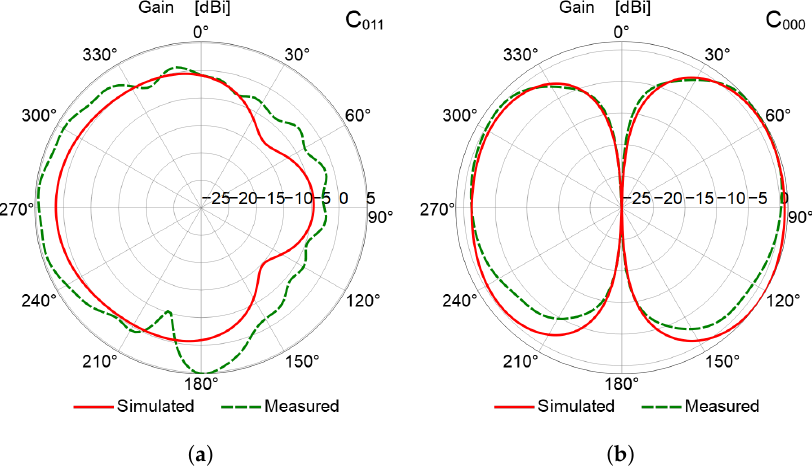
Figure 4. Simulated and measured realized gain patterns in the vertical plane for the configurations ( a ) C 011 , and ( b ) C 000